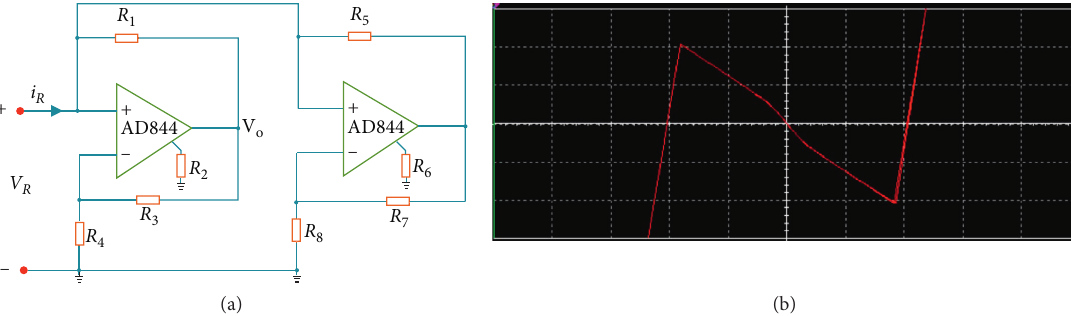
Figure 9: Five-segment piecewise nonlinear resistance implemented by two CCIIs: (a) circuit structure and (b) V –I characteristic simulated by